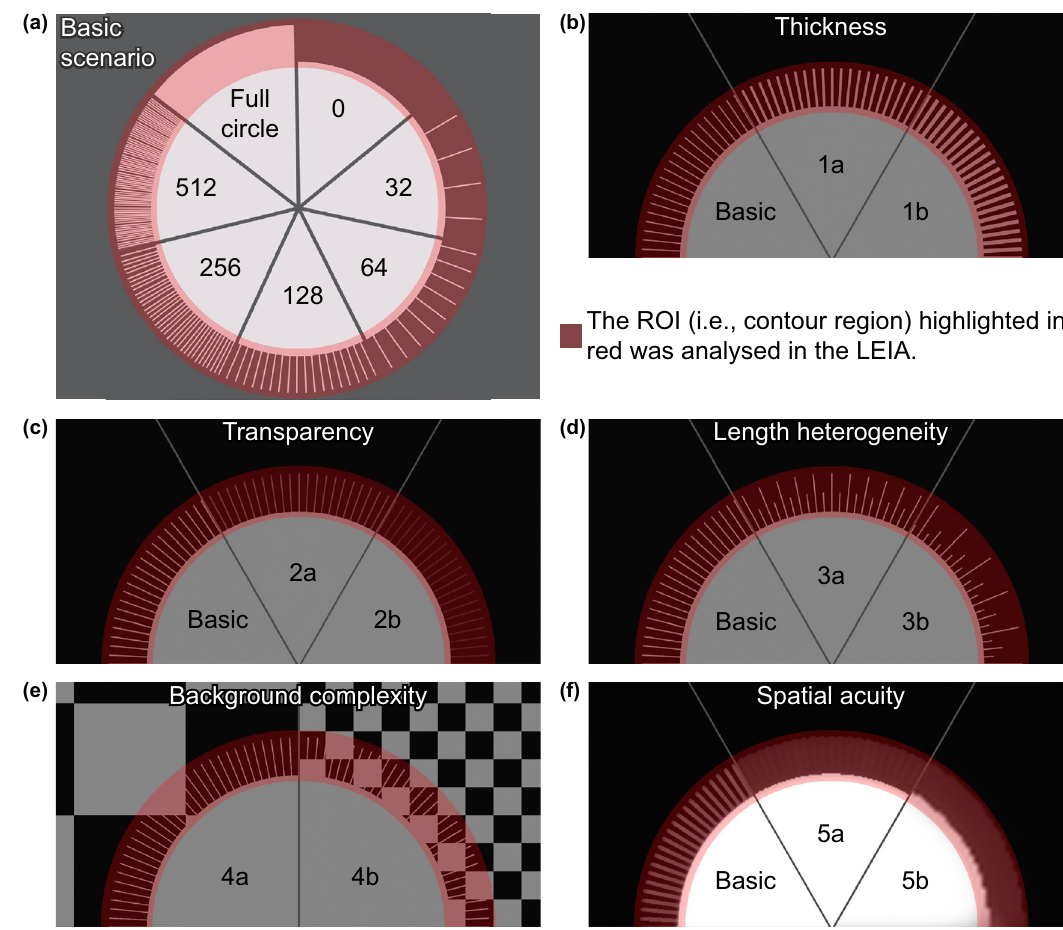
Figure 3. (a) Basic Scenario: Seven stages of the artificial chick setup with varying number of thin, non- transparent appendages having all the same length. (b) Scenario 1: varying appendage thickness applied to the Basic Scenario. (c) Scenario 2: varying appendage transparency applied to the Basic Scenario. (d) Scenario 3: varying appendage length heterogeneity applied to the Basic Scenario. (e) Scenario 4: varying background complexity with chessboard backgrounds. (f) Scenario 5: high, medium and low spatial acuity applied to the Basic Scenario. ( a–f ) The analysed region of interest (ROI) is highlighted in red for clarification only. The figure was produced in Adobe Photoshop 29 and InDesign 30